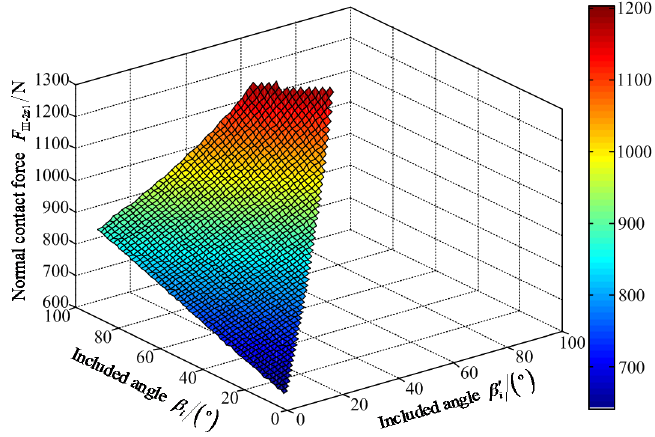
Figure 20. Variable tendency chart of normal contact force F III-2 z 1 with the changes of β i (cid:48) and β i .